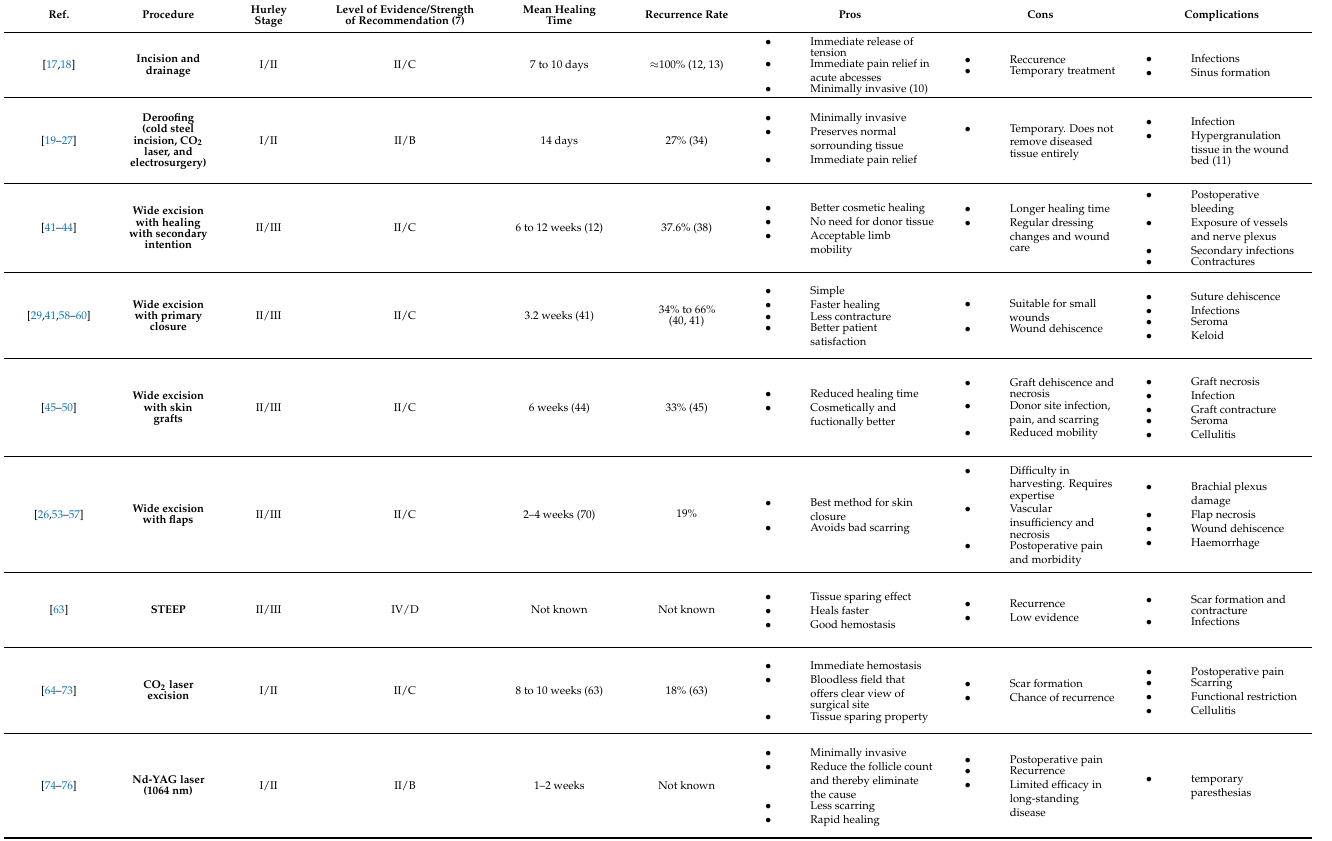
Table 1. Summary of Surgical Procedures in Hidradenitis Suppurativa.